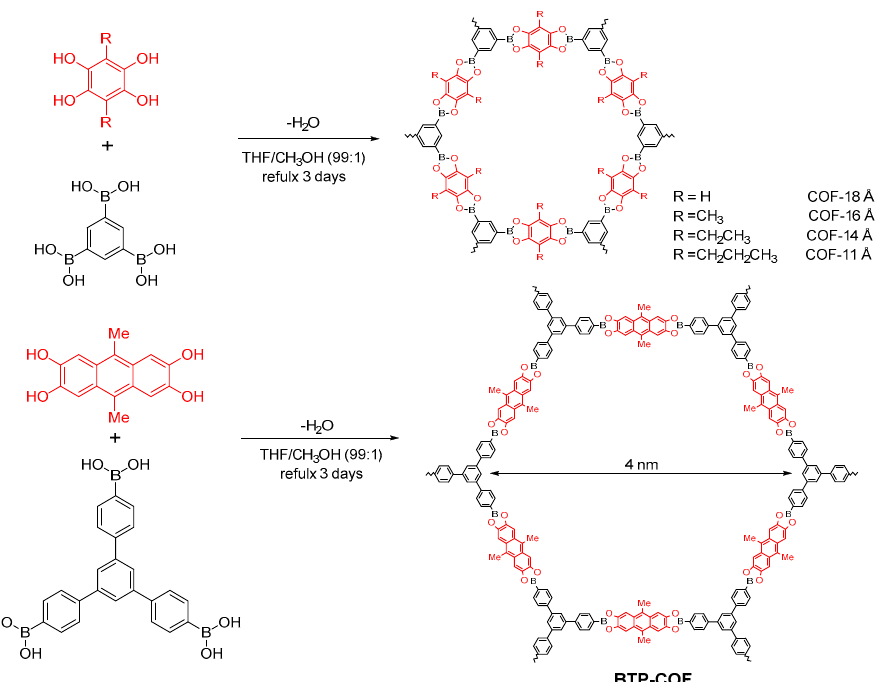
Figure 4. Construction of dioxaborole-linked COFs via the cross-condensation of ditopic catechol-based linkers with tritopic boronic acids to form the 2D honeycomb layer structures. The pore sizes can be modulated by the decorated functionalities of the ditopic linkers, and expanded by elongating both the boronic acid and catechol linkers.